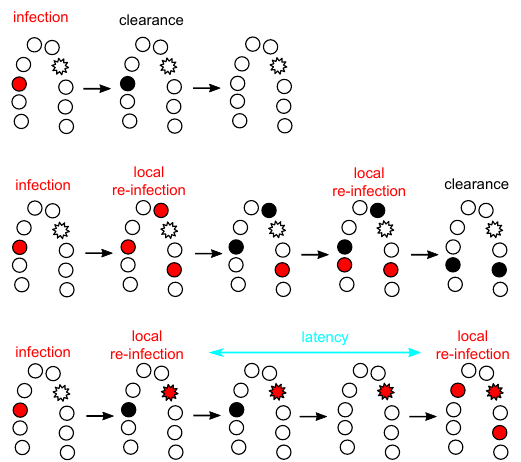
Figure 4. The meta-population hypothesis for HPV kinetics, exemplified in the cervix. Each circle represents a population (i.e., a cellular patch or a site) that can be susceptible (white), infected (red), or recovered from infection (black). The star-shape indicates a cellular patch that can remain infected for a longer time than the regular sites and can act as a source site if infected. For simplicity, recovered sites are here assumed to transitorily exhibit higher local immunity and resource depletion, thus making it unable to allow for re-infection. The top line shows a case with a local acute infection that is cleared without reaching other patches. The middle one shows the meta-population dynamics of local re-infection from an initial patch, without cell heterogeneity. The bottom line shows a case with patch heterogeneity (source-sink